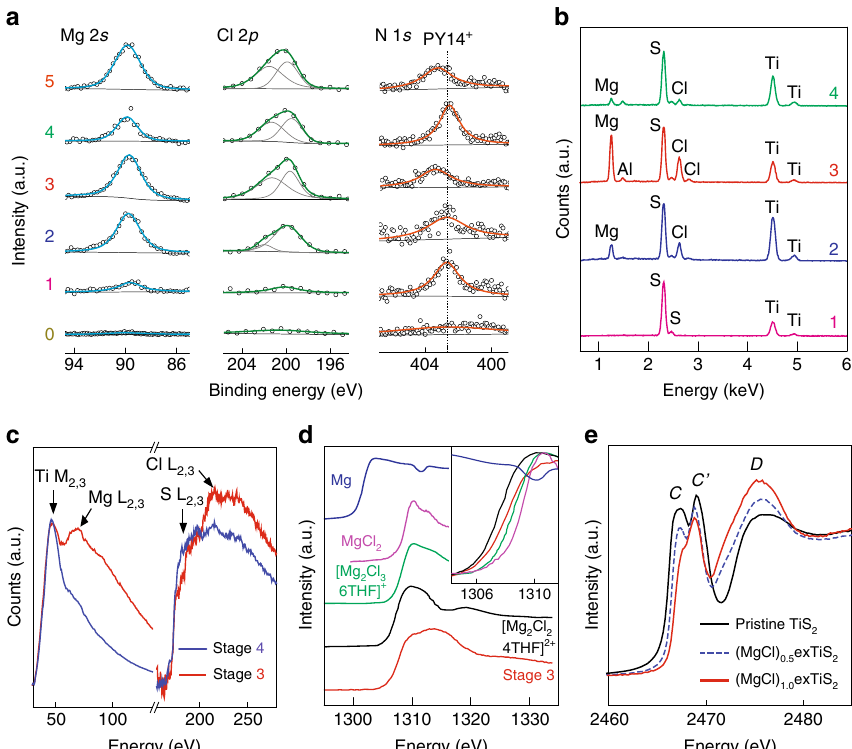
Fig. 4 Chemical nature of the intercalation compound at each stage. a XPS spectra of Mg 2 s , Cl 2 p , and N 1 s for stages 0 to 5. b EDS spectra for stages 1 to 4. c EELS spectra at stages 3 and 4. d Mg K -edge NEXAFS spectra of Mg metal, MgCl 2 powder, [Mg 2 Cl 2 · 4THF] 2+ (Nakayama et al. 50 ), [Mg 2 Cl 3 · 6THF] + (Benmayza et al. 51 ), and magnesiated exTiS 2 at stage 3. e Experimental S K -edge NEXAFS spectra for TiS 2 ( black ), (MgCl) 0.5 exTiS 2 ( blue, dashed ), and (MgCl) 1.0 exTiS 2 ( red